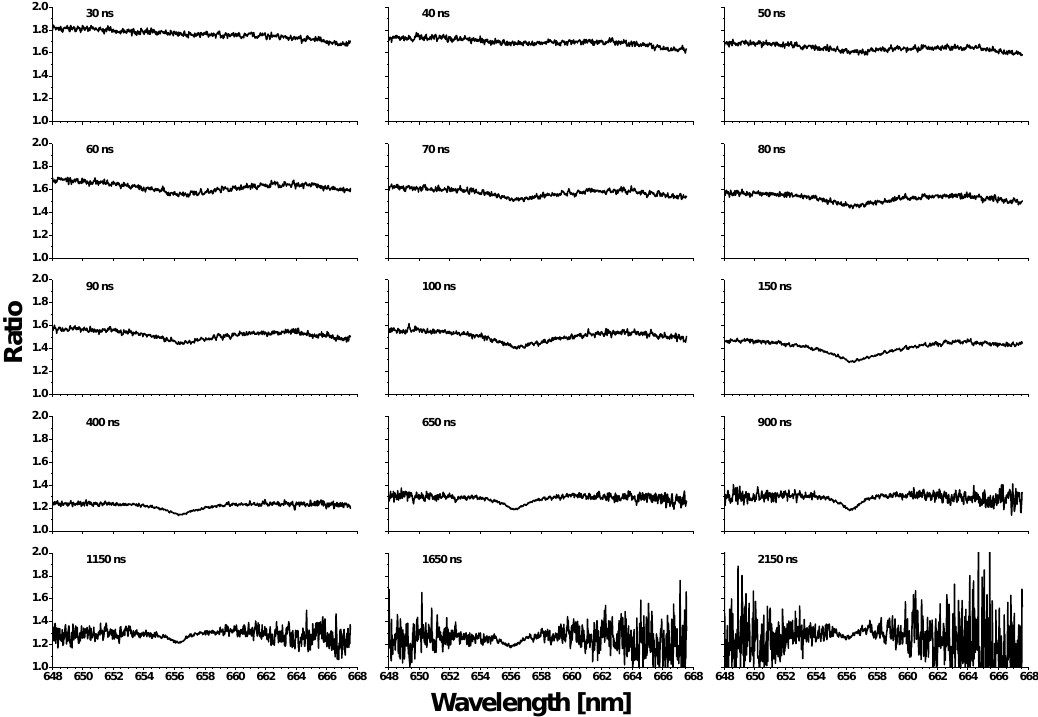
Figure 5. Ratios of the doubled H α spectra to the non-doubled emissions through the plasma decay from 30 ns to 2150 ns. Each image has the wavelength and ratio